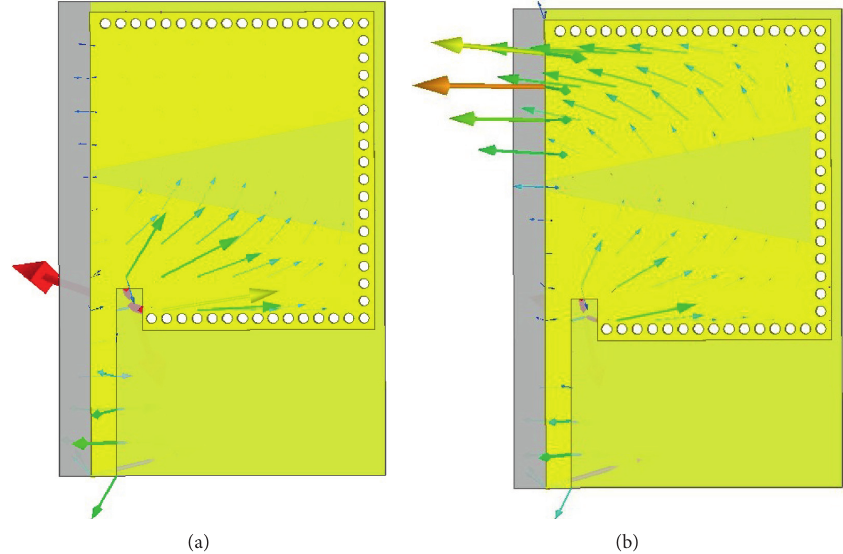
Figure 5: Simulated H-field vector distributions of the hybrid modes in the HMSIW structure at (a) 3.8GHz and (b) 3.98GHz.